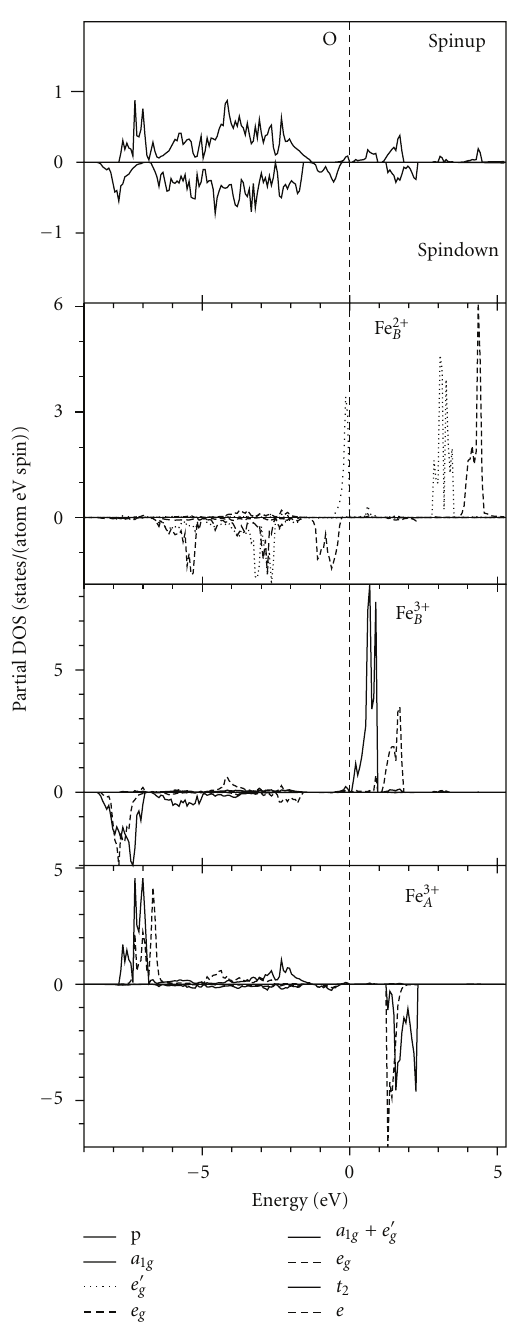
Figure 4: LSDA+ U partial DOS of Fe 3 O 4 [10].